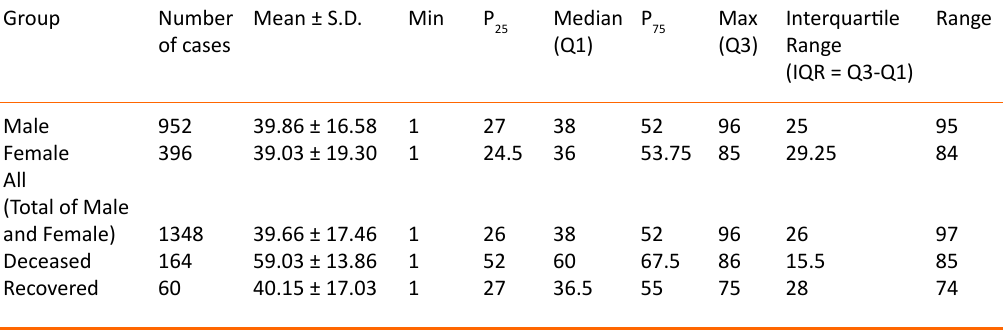
table 1. Statistical analysis of COVID-19 cases for different groups Group Number Mean ±